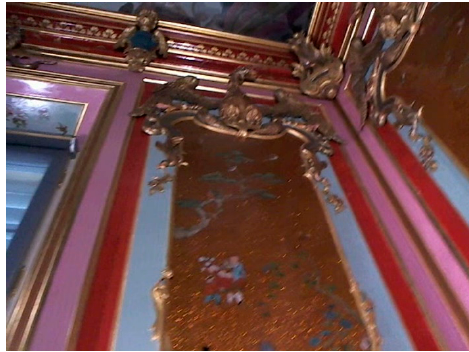
Figure 11. Example of the details under a high ceiling.